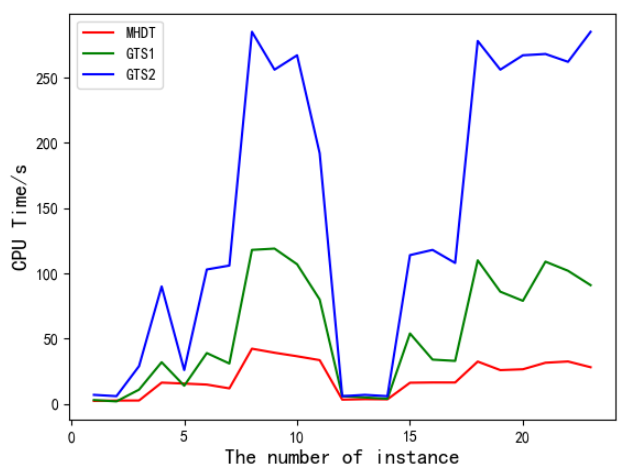
Figure 11. Result of the initial solutions of instance 1. Figure 11. result of the initial solutions of instance 1.